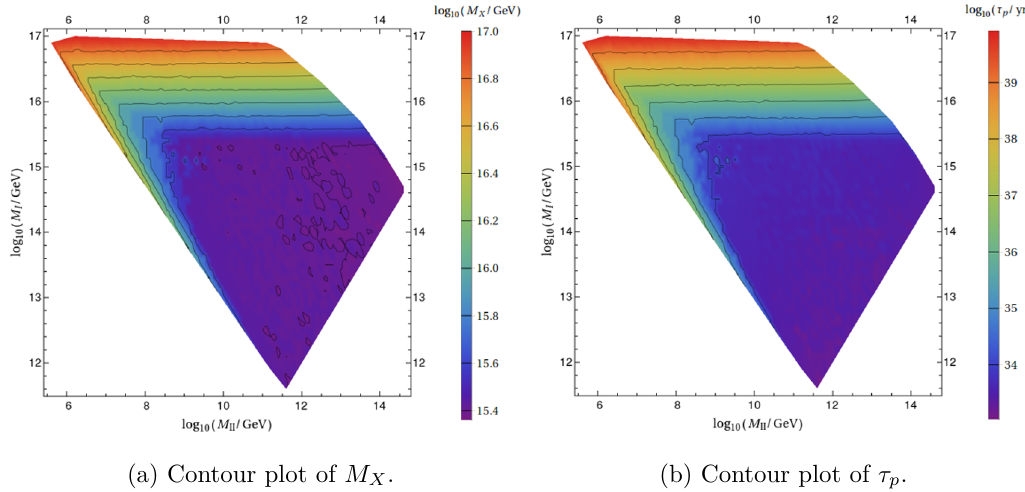
(a) Contour plot of M Figure 6. Contour plots for the E 6 breaking chain in section 3.4, where the VEV of (1 , 3 , 1 , − 2) ⊂ 351 0 causes the symmetry breaking G